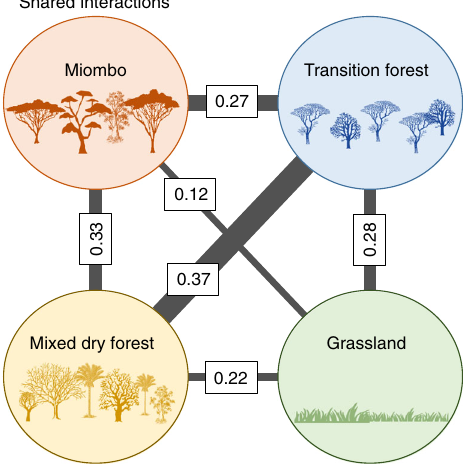
Fig. 6 Similarity in terms of shared interactions, between the habitat pairs of Gorongosa. Similarity is assessed using the edge overlap between the habitats in the spatial multilayer network, i.e., proportion of shared links across habitats. The width of the links is proportional to the correlation between each habitat pair. The silhouettes used in this fi gure are all sourced from Open Clipart and were made available under a CC0